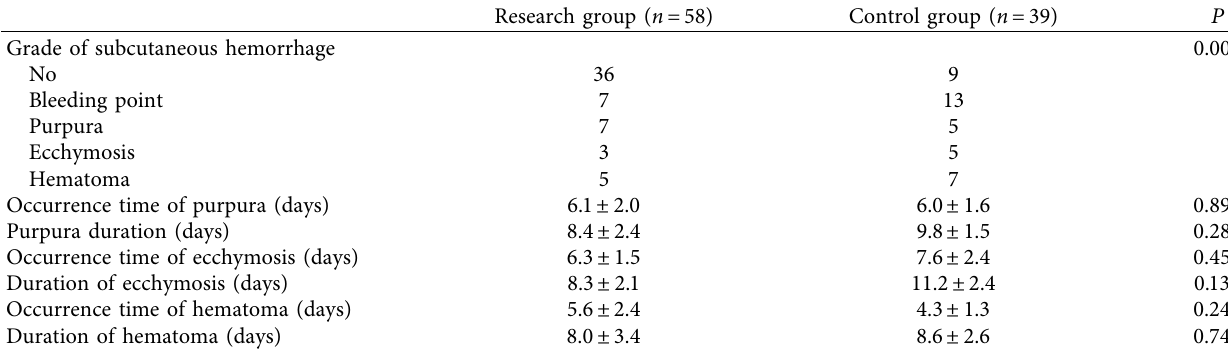
Table 3: Subcutaneous bleeding